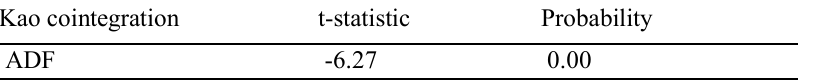
Table 2. Results of panel cointegration test using the Kao test for cotton crop Kao cointegration t-statistic